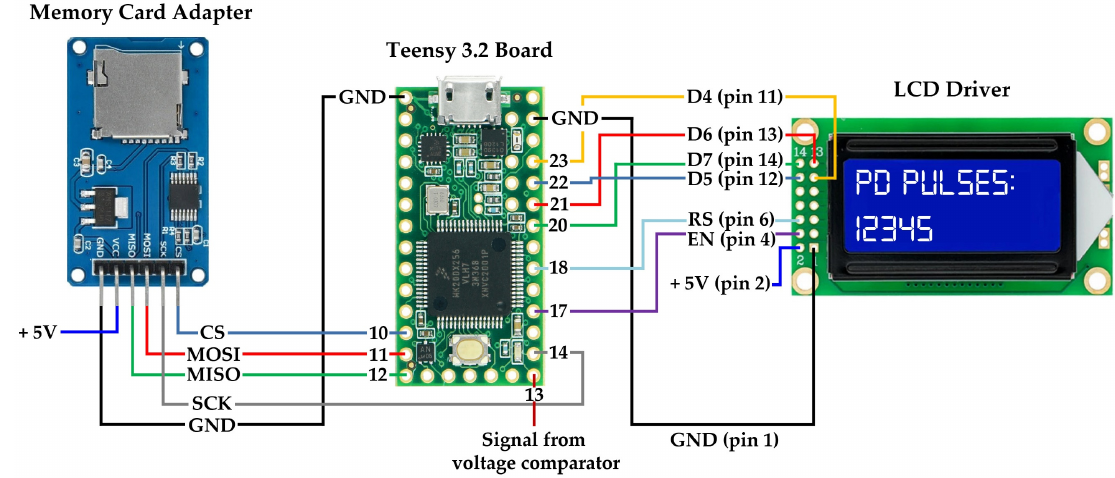
Figure 6. The schematic diagram of connecting the microSD card adapter and the 14-pin LCD driver to the Teensy 3.2 board.